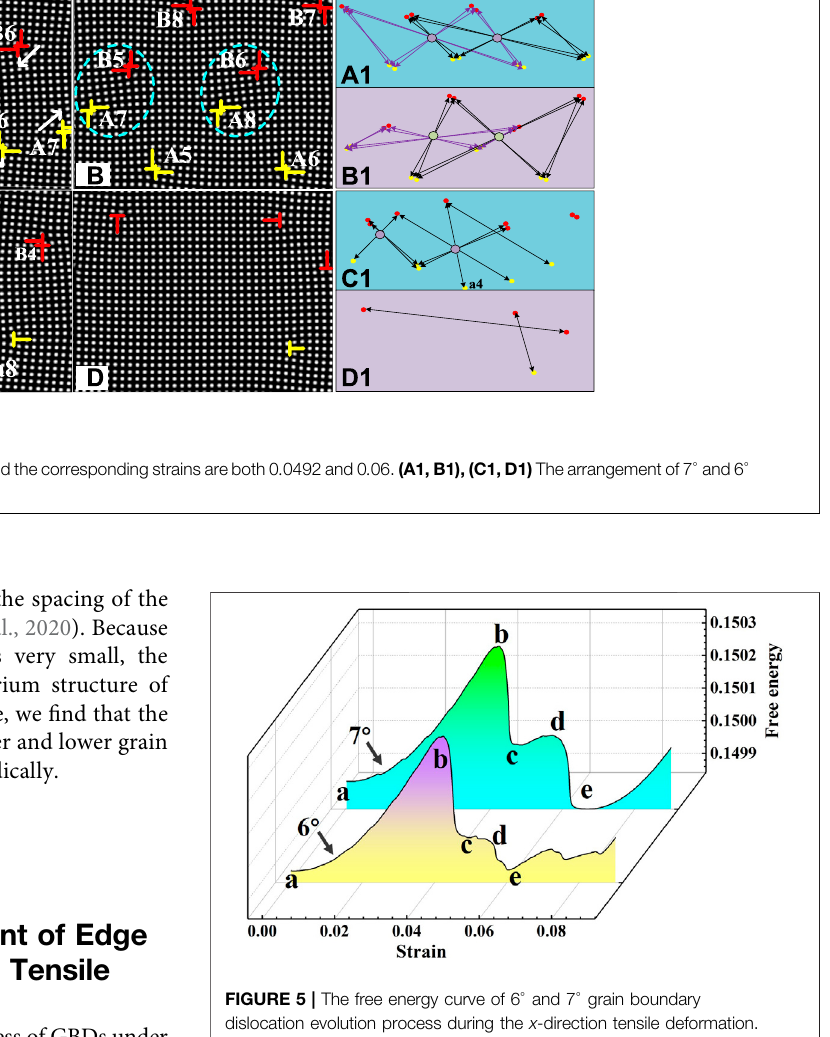
Frontiers in Materials |